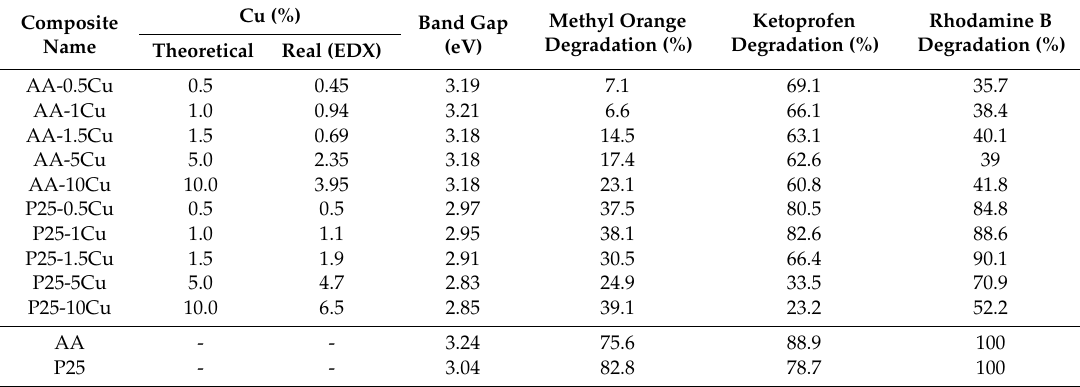
Table 1. The theoretical and real content of Cu in the composites, and the band gap energies and the degradation e ffi ciencies (for methyl orange and ketoprofen) of the composites. EDX = energy-dispersive X-ray